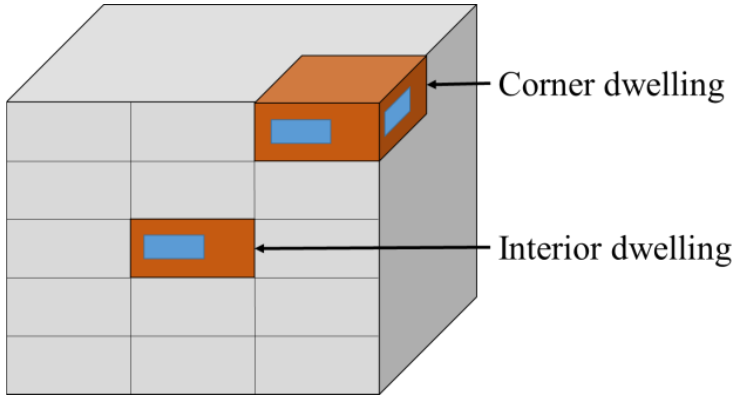
Figure A1. Dwelling locations used in simulations.